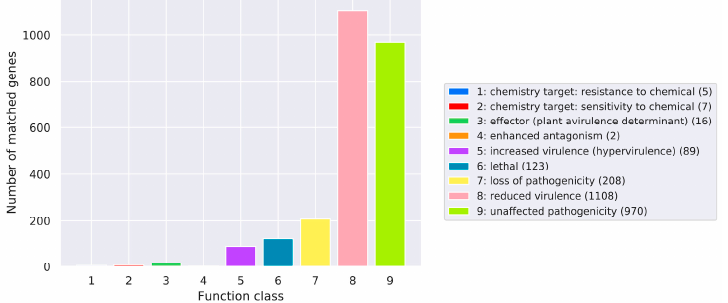
Figure 3. Distribution of the mutation types in the pathogen-PHI phenotype of C. pseudotenuipes . Carbohydrate Genes